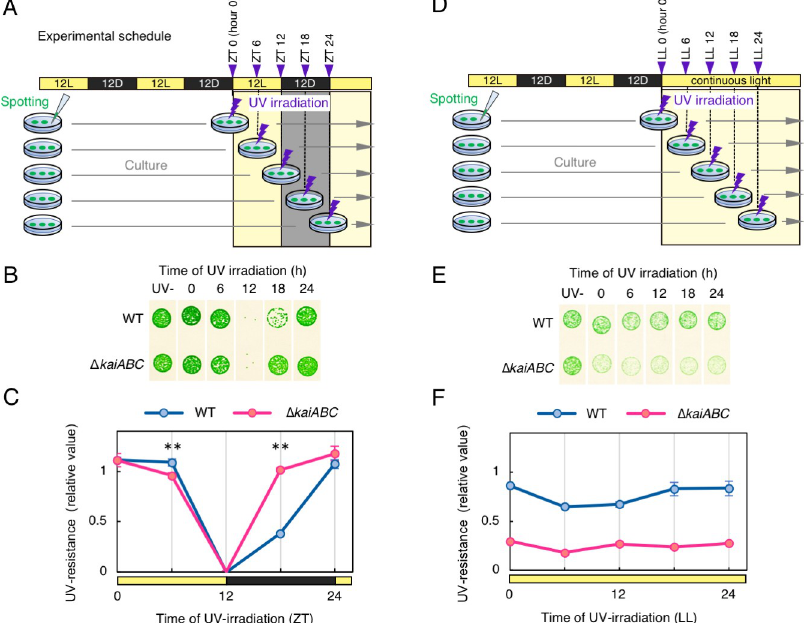
Fig 1. Diurnal variation of UV-C resistance of Synechococcus . (A) A schematic representation of the experimental schedule. Yellow and black bars indicate the light (L) and dark (D) periods, respectively. The cells were spotted onto agar plates, synchronized to two 12-h:12-h LD cycles and then irradiated with UV-C at each time point (arrowhead). (B) Growth of UV-C-irradiated cells (WT, wild-type; Δ kaiABC , kaiABC -deficient strain). Each image represents a spot assay to assess growth following UV irradiation at each time point of the 12-h LD cycle. Representative data of three independent experiments are shown. (C) Densitometric analysis of the growth test shown in Fig 1B. The timing of UV-C irradiation is shown on the horizontal axis, whereas the densitometric value of the spots as an index of cell growth and representing UV-C resistance of each strain is shown on the vertical axis. The value was normalized to that of the negative control (without UV; n = 3). Error bars represent standard deviation. The UV resistance in the WT and Δ kaiABC strains at ZT 18 significantly differ. � P < 0.01 (Student’s t-test). (D) A schematic representation of the experimental schedule (UV+L condition). Each symbol is the same as in Fig 1A. After UV-C irradiation, the cells were exposed to continuous light. (E) Growth of the UV-C irradiated cells (WT, wild-type; Δ kaiABC , kaiABC -deficient strain). Each image represents a spot assay to assess growth following UV irradiation at each time point (upper label) under UV+L condition. Representative data of three independent experiments are shown. (F) Densitometric analysis of the growth test shown in Fig 1E. Each axis and normalization are the same as in Fig 1C. Detailed data used for figures on this article are provided in S1